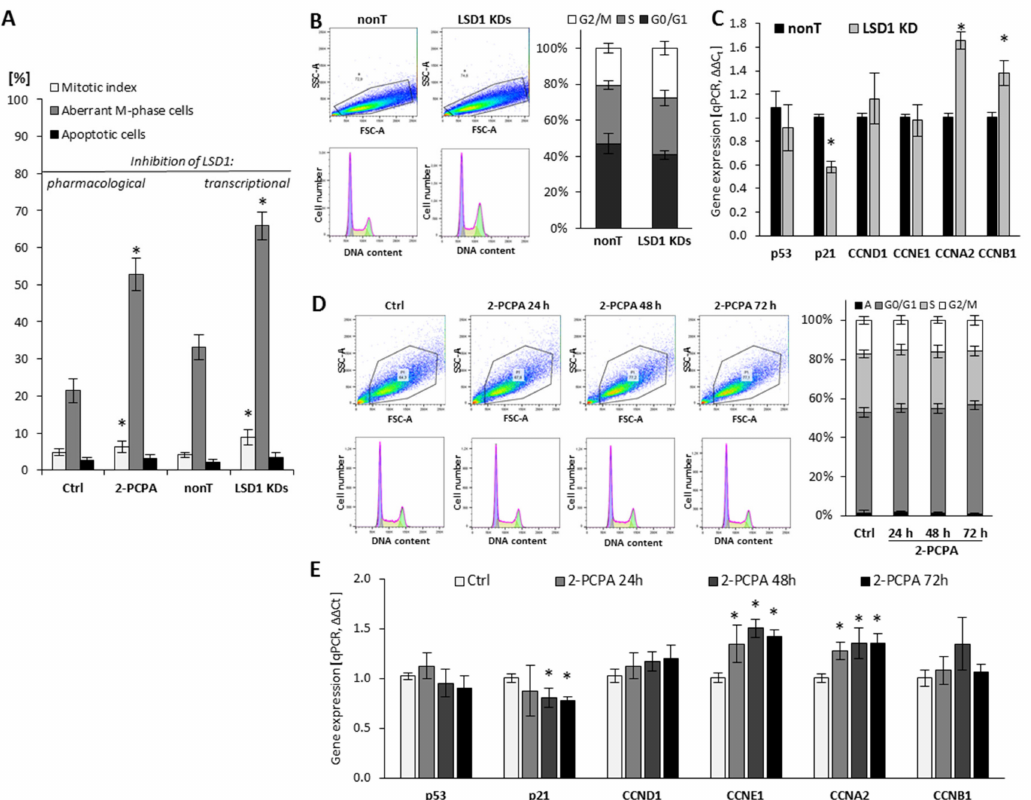
Figure 1. E ff ect of pharmacological and transcriptional inhibition of lysine-specific demethylase 1 (LSD1) on cell cycle progression of human microvascular endothelial cells (HMEC-1). ( A ) The e ff ect of LSD1 shutdown due to 2-phenylcyclopropylamine (2-PCPA) treatment or shRNA transfection on the mitotic index, the induction of aberrations in the M phase of cell cycle and apoptosis (MI, a percentage of mitotic cells in relation to all cells, both interphase and mitotic). The percentages were calculated based on 3000 cells per repeat; ( B , D ) Flow cytometry analysis of cell cycle. Cells were stained with propidium iodide. The obtained histograms were analyzed using FlowJo software 10.4.1. (“A” stands for the subpopulation of apoptotic cells). Presented histograms are representative of three independent experiments; ( C , E ) Gene expression profile of cell cycle regulators in HMEC-1 treated with 100 µ M of 2-PCPA ( E ) or after transcriptional LSD1 silencing by specific shRNA ( C ). Presented data are average of three independent experiments. The level of significance was determined at * p < 0.05, ANOVA and post hoc analysis by Tukey’s